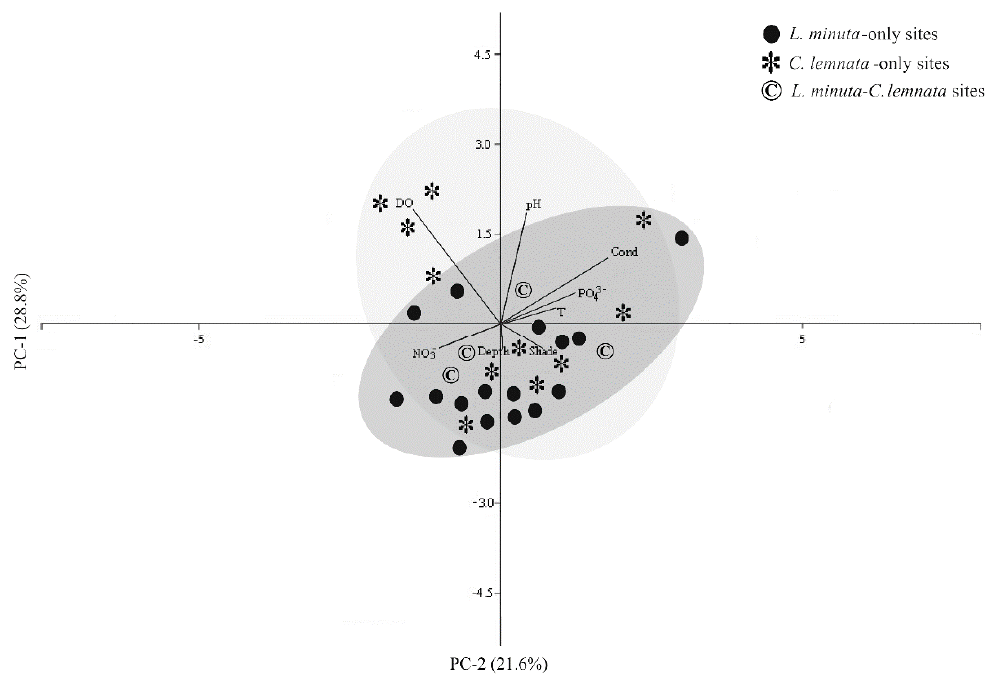
Figure 2. Ordination scattergram (PCA) based on environmental variables measured at sites with only Lemna minuta ( L. minuta -only sites), with only Cataclysta lemnata ( C. lemnata -only sites), and plant and insect co-occurring at the same time ( L. minuta - C. lemnata sites). Table 2. Pairwise comparisons between site groups ( L. minuta -only sites, C. lemnata -only sites, L. minuta - C. lemnata sites) by the ANOSIM test. Probability values related to similarity between site groups are reported ( p < 0.05; significantly dissimilar